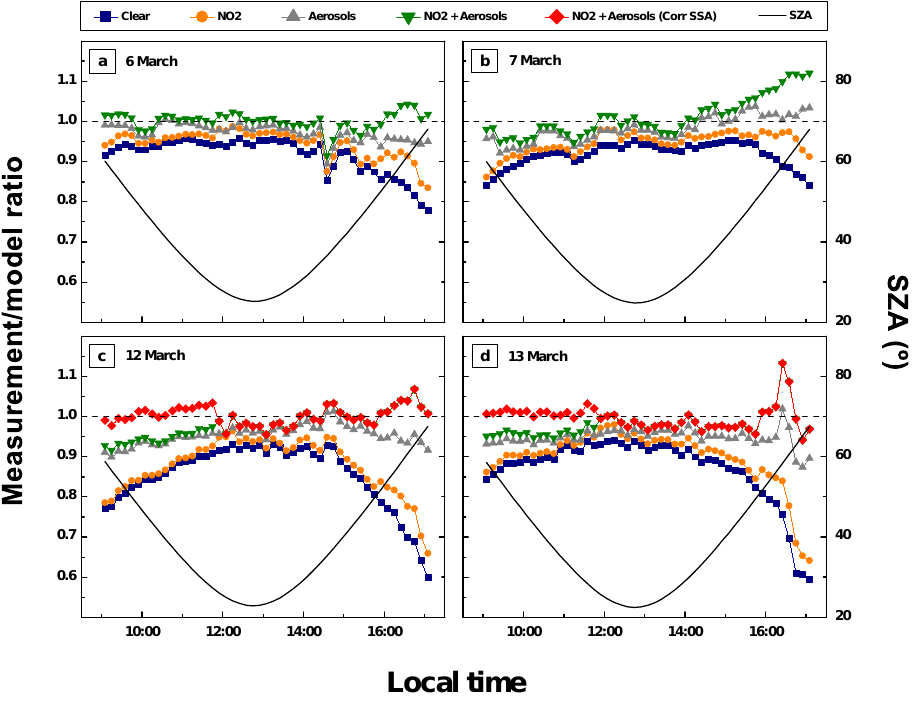
Fig. 2. Actinic flux ratios (measurement/model) for four cloudless days. Symbols and colors correspond to different conditions used for the calculations. Dashed horizontal line corresponds to measurement/model ratio equal to